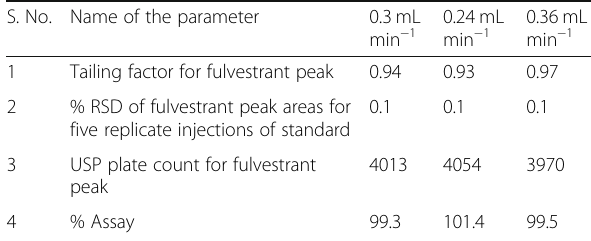
Table 7 Results of effect of variation in flow rate